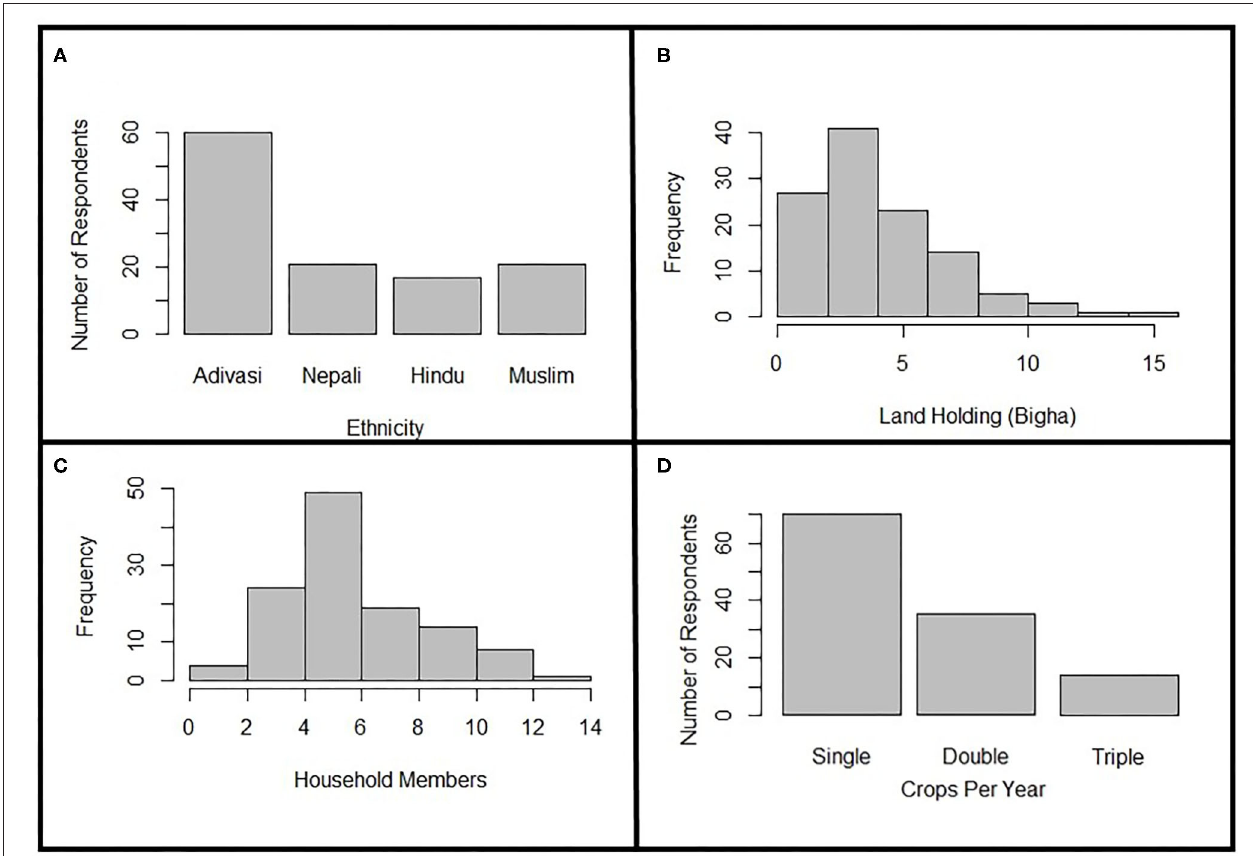
FIGURE 2 | Figure showing (A) Ethnicity of respondents; (B) Land holding pattern; (C) Household strength; and (D) Cropping patterns in our study site in North-Eastern India.